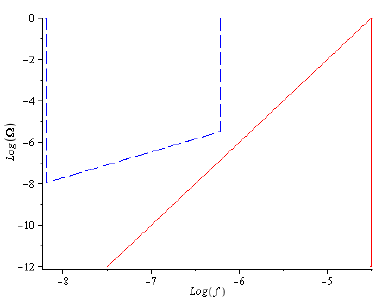
Figure 3: Gravitational wave background limit from pulsar timing (dashed line) , and our inferred gravi- tational wave background from stimulated emission of gravitational waves from the background Planck sea constituting dark energy (straight line). The ordinate is the fraction of closure density Ω per log bin of fre- quency, and the abscissa is the frequency of the gravi- tational waves f .